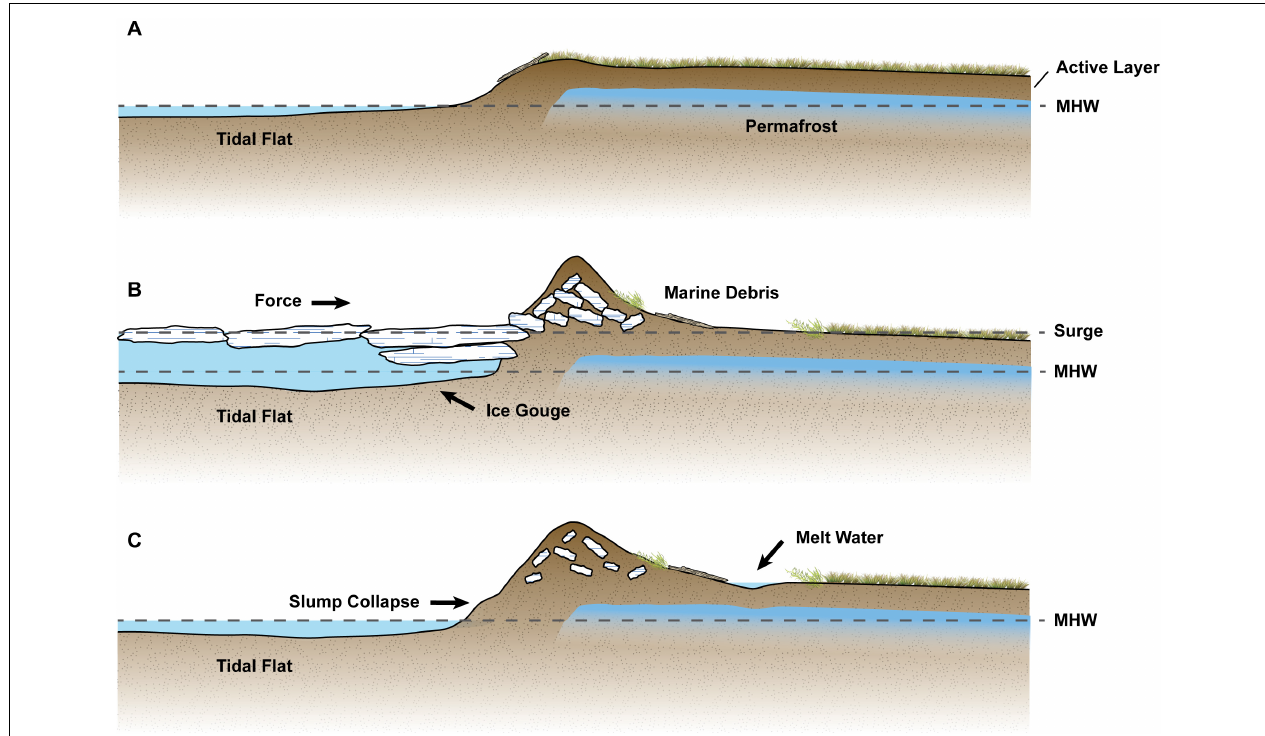
FIGURE 8 | Conceptual diagram showing the before (A) , during (B) , and after (C) cross-sections of the Eastern portion of the coastline ( Figure 3 ). Key features are annotated with the arrows. (A) Undisturbed coastline prior to the ivu depicting bluff consisting primarily of unconsolidated wind-blown sand. (B) During the event, ice, sediments, and other marine debris were piled on top of the bluff. (C) Ivu debris pile as it was surveyed and documented 5 months after the ice push. MHW, mean high water.